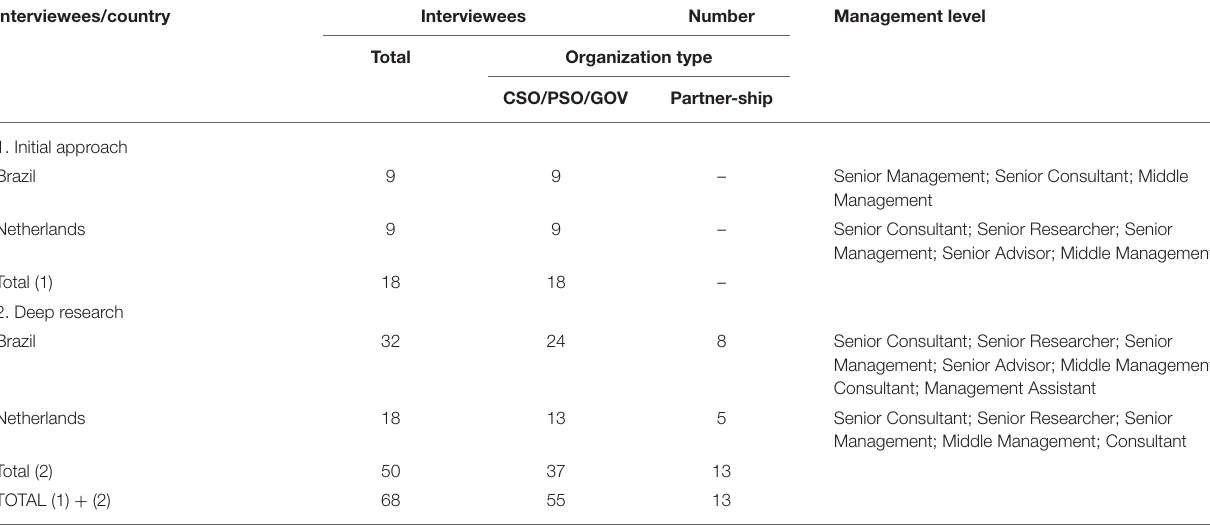
TABLE 1 | Interviewees by type of organization and management